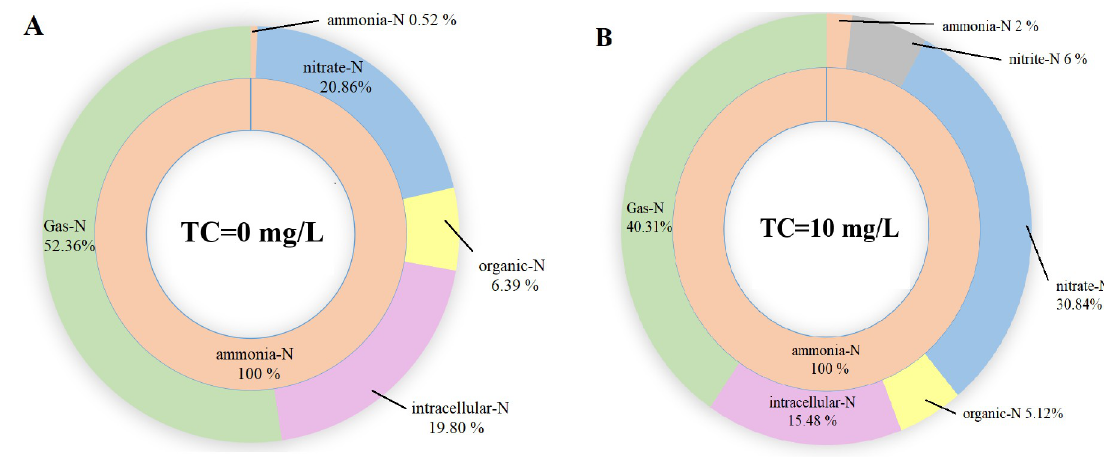
Fig 4. The balance of nitrogen in MBBR under TC = 0 mg/L (A) and TC = 10 mg/L (B).